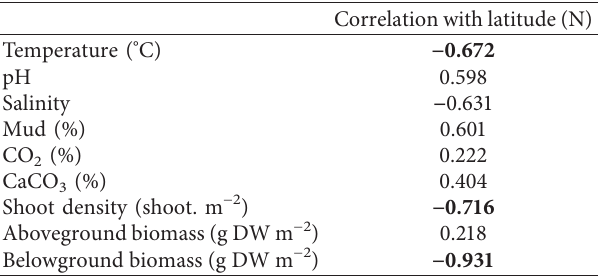
Table 2: Pearson’s correlation coefficients ( r ) for the relationships between latitude and each of the environmental variables used for this